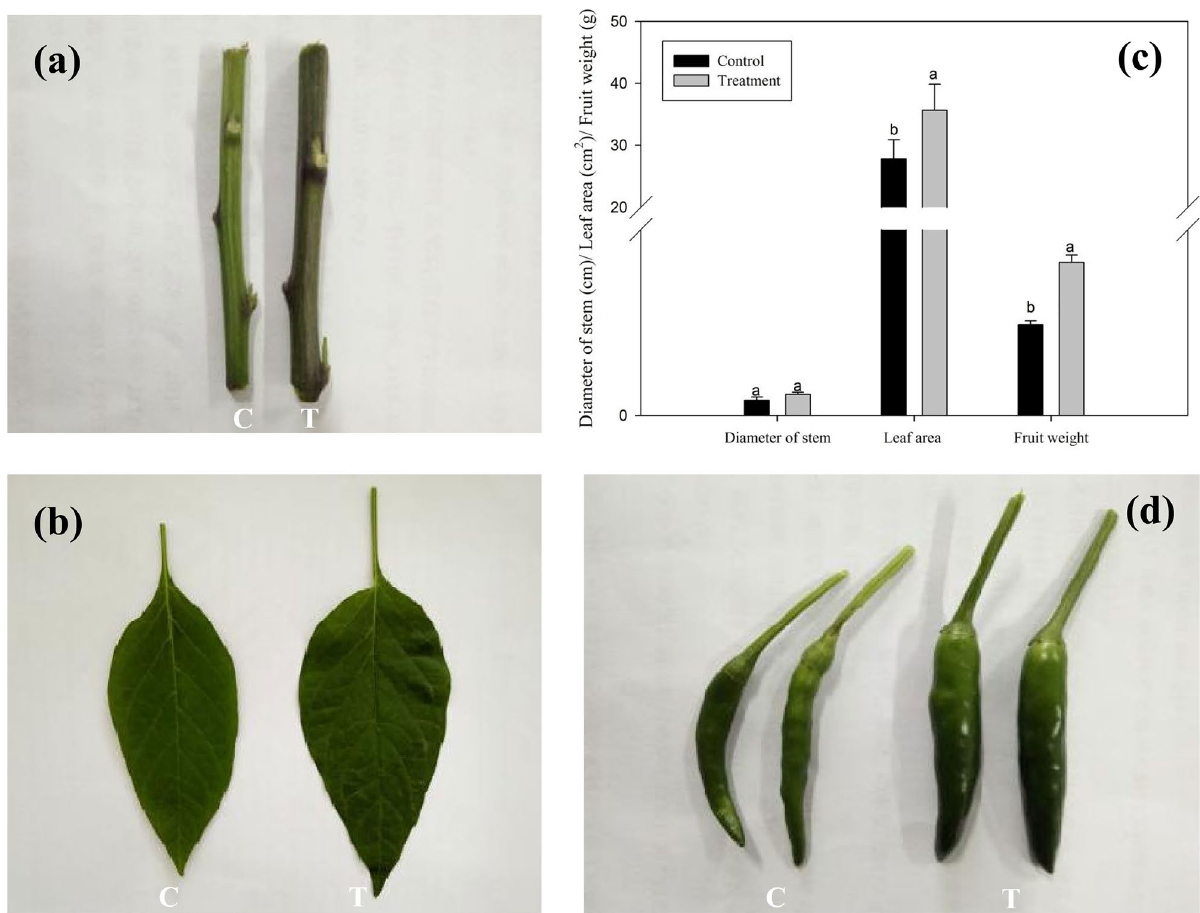
Figure 2. Effects of Chlorella extracts on the stem diameter, leaf area and fruit growth of pepper. The stem diameter, leaf area and fruit weight were measured on the 21th day after Chlorella extracts treatment. Control: no Chlorella extracts treatment; Treatment: plants were treated by Chlorella extracts; “C” means “Control group”, and “T” means “Treatment group”. SAS analysis at 5% is shown in lowercase letters to indicate significant differences. Vertical bars in the figures represent ± SD of five independent biological